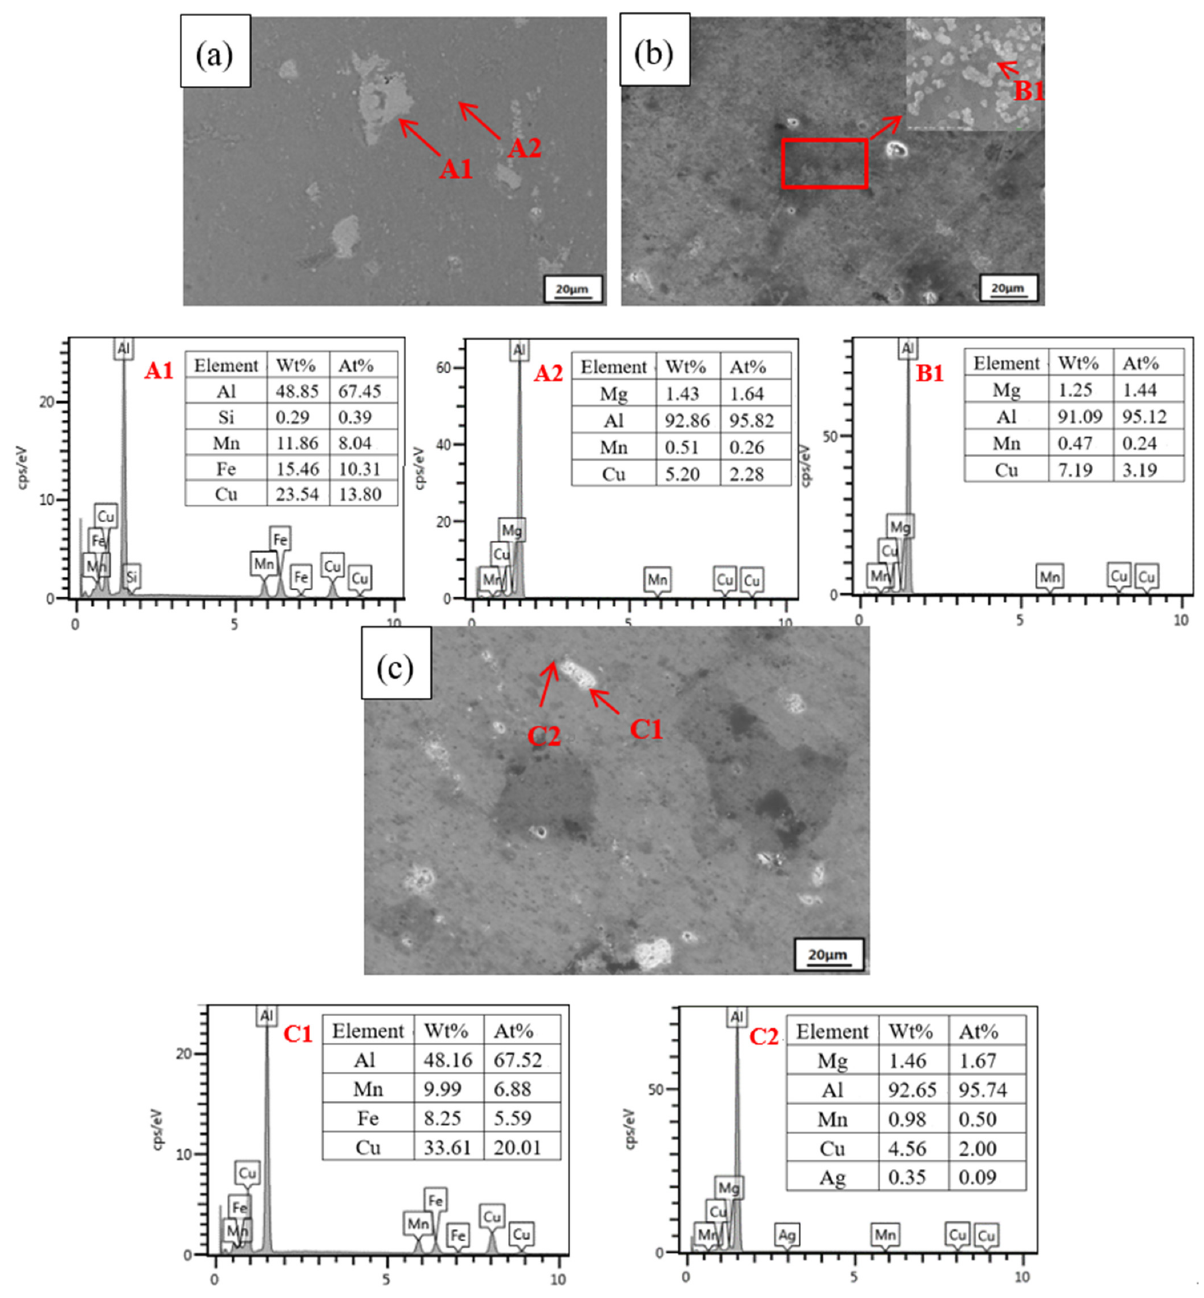
Figure 12. SEM images and EDS results of the 2024 FSWed joints second phase with different deformations ( a ) 0%, ( b ) 4%, ( c ) 7%, A1 is welding nugget of 0% sample, A2 is second phases in 0% sample, B1 is second phases in 4% sample, C1 is welding nugget of 7% sample, C2 is second phases in 7%